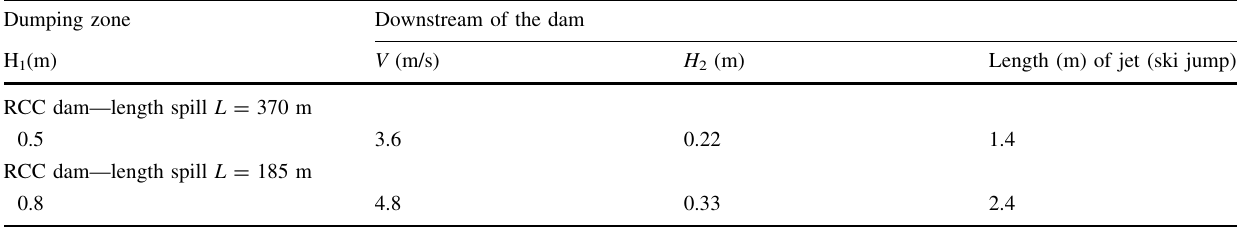
Table 3 Results of hydraulic calculations—RCC dam variant Dumping zone